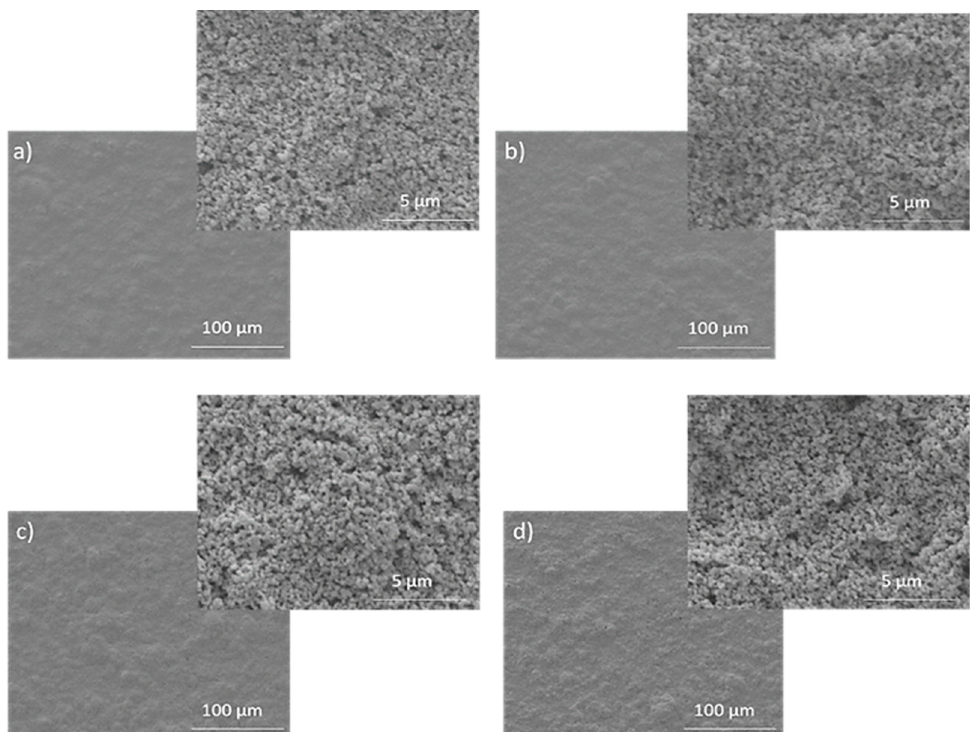
Figure 5. SEM images of the surfaces of the electrodes produced using ( a ) ink_25, ( b ) ink_35, ( c ) ink_45, and ( d ) ink_55.